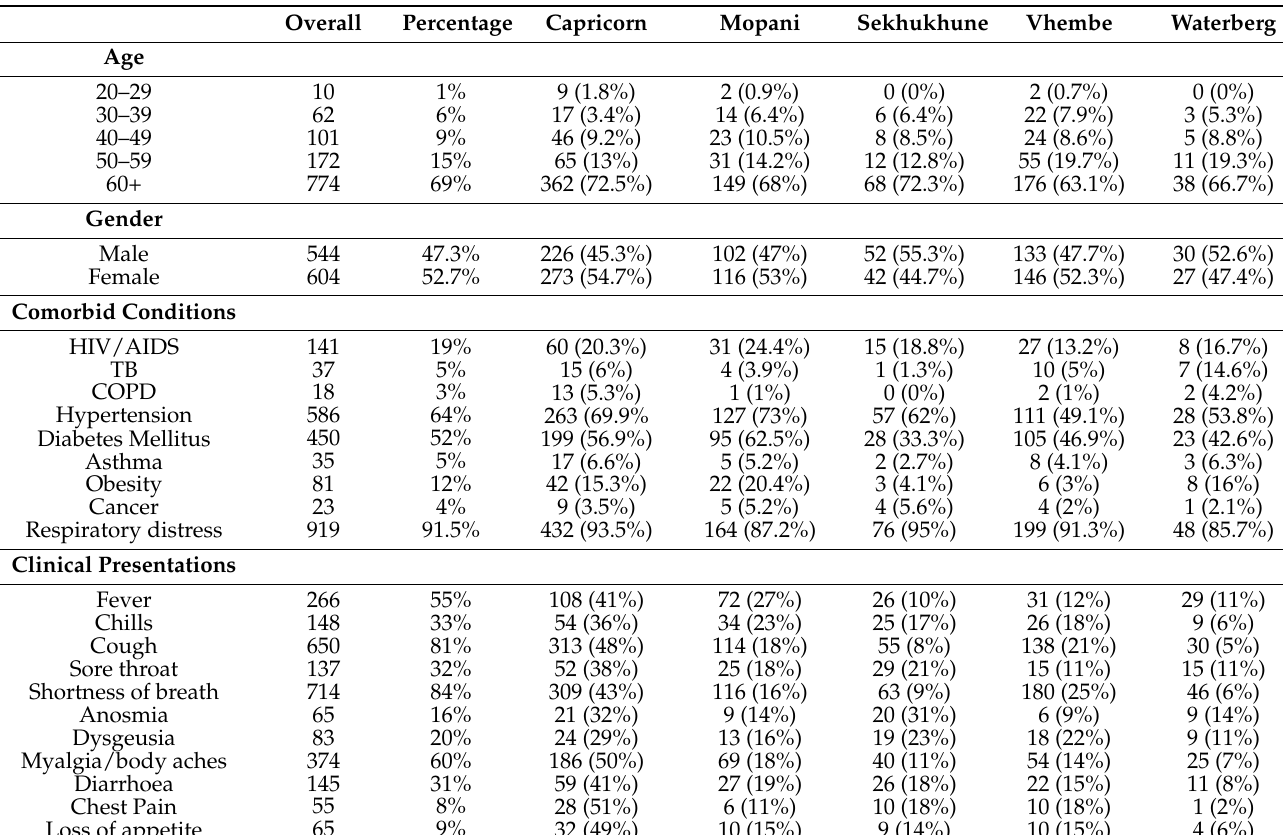
Table 1. Demographic and clinical characteristics of hospitalised patients with